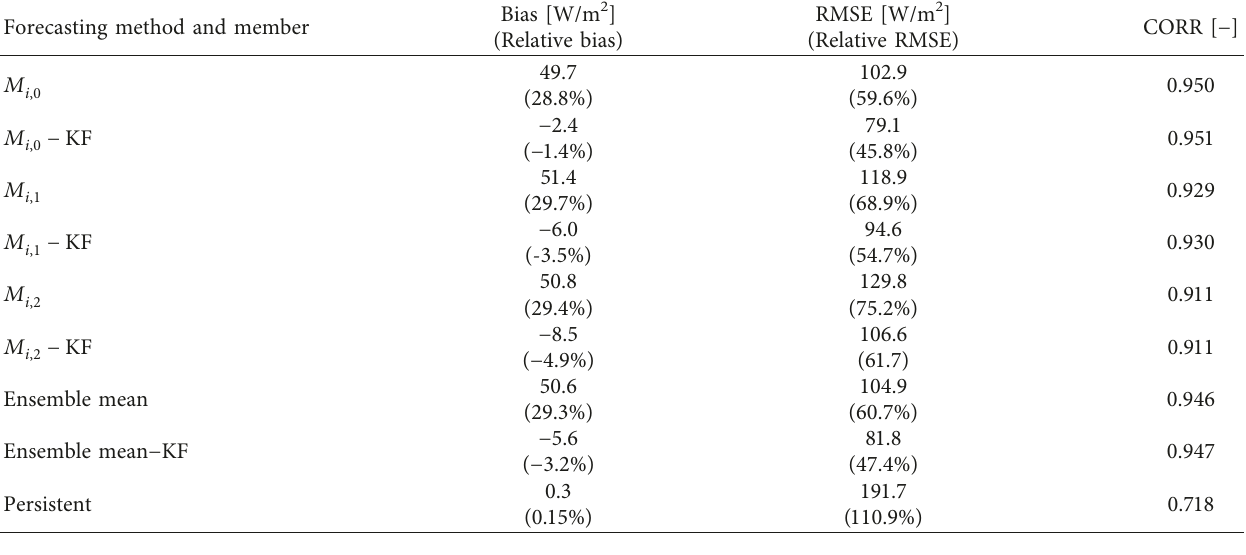
Table 2: Statistical indexes for solar GHI different